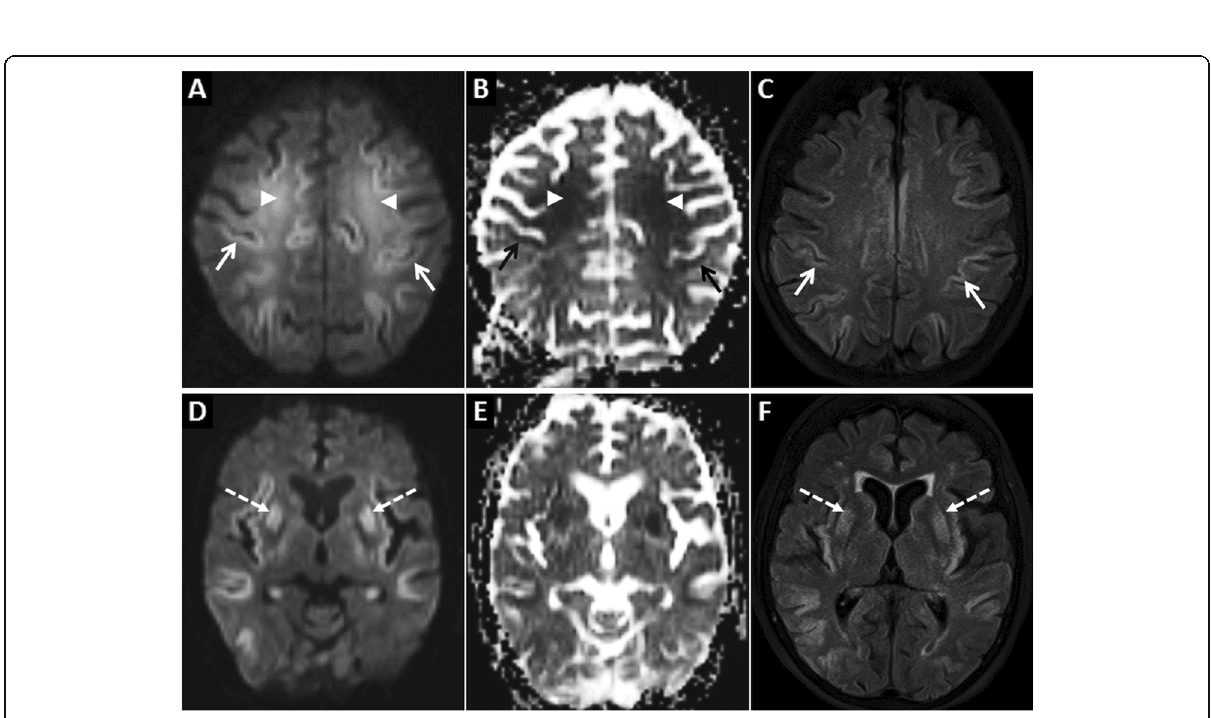
Fig 4 MRI of the brain in a 68-year-old male patient presenting with severe hypoglycaemia. Extensive symmetric GRD (arrows) and restricted diffusion in deep white matter (arrowheads) is seen on axial DWI ( a ) and ADC image ( b ). Restricted diffusion is also seen in the putamina bilaterally (dashed arrow) on axial DWI ( d ) and ADC image ( e ). Axial FLAIR images ( c , f ) show hyperintense signal in the involved cortex (arrows) and in the putamina (dashed